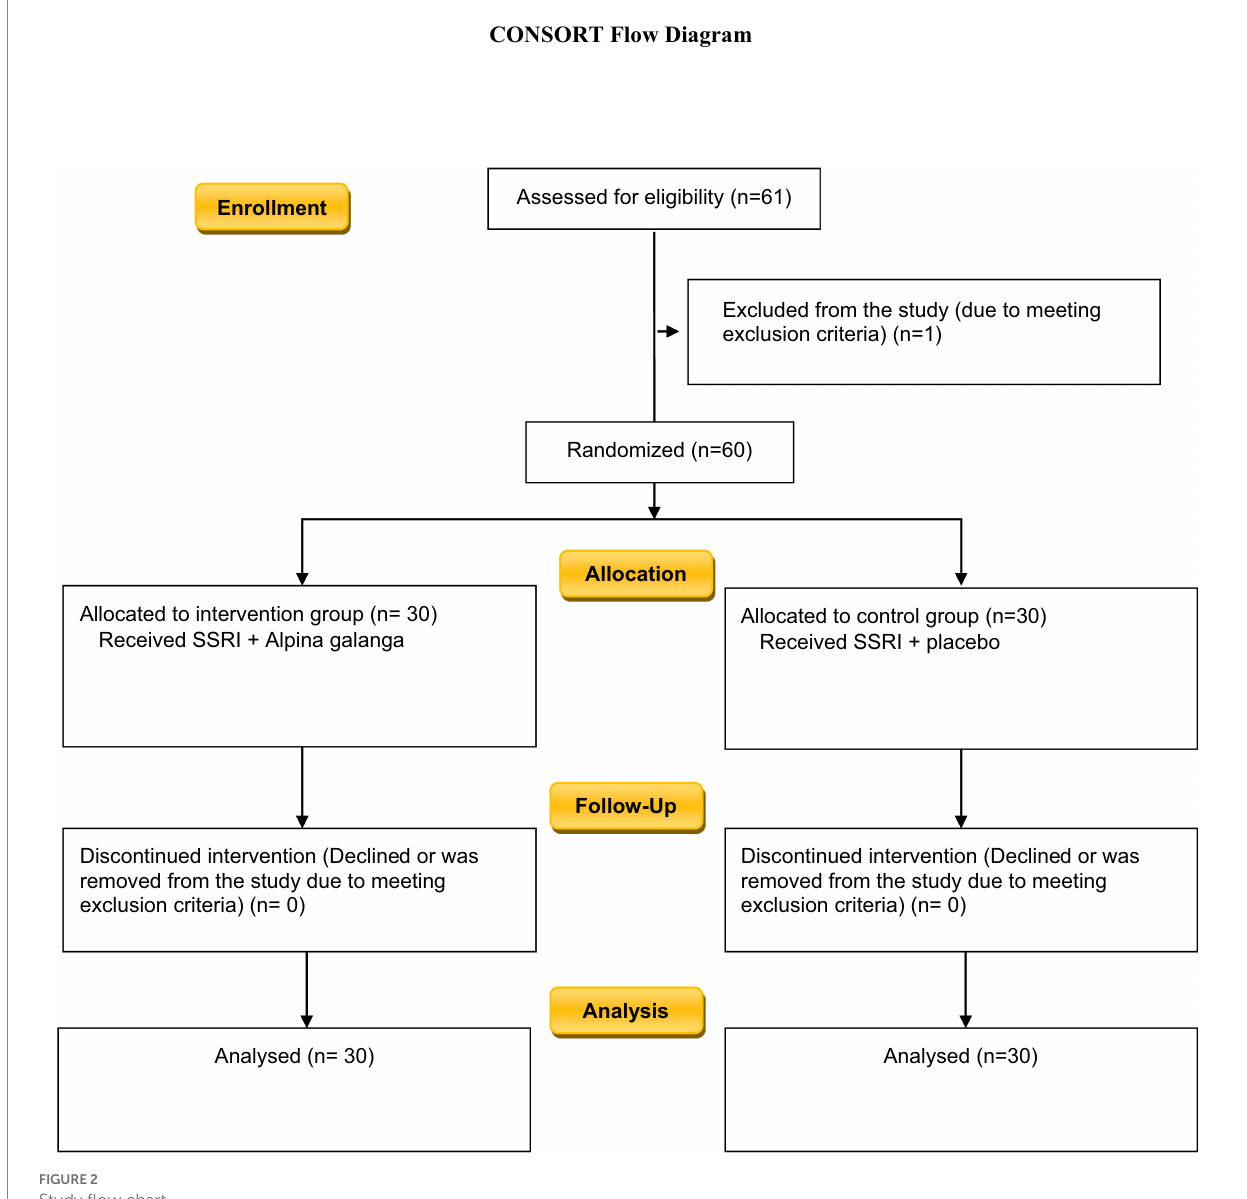
FIGURE 2 Study flow